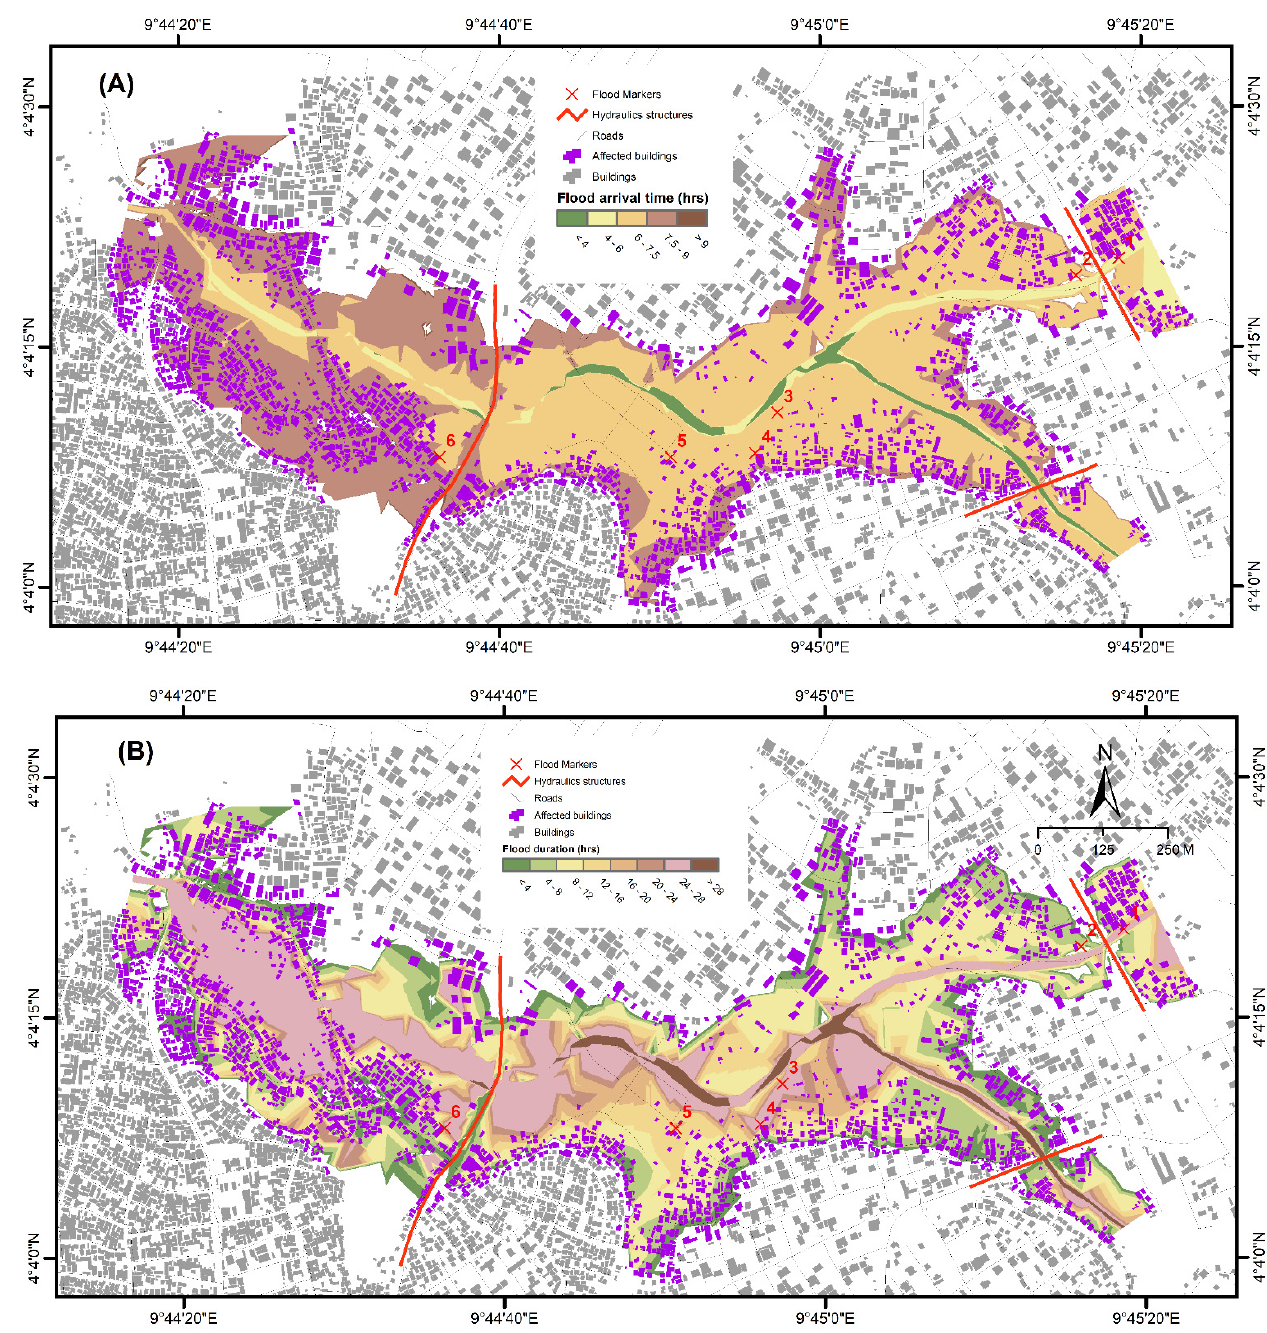
Figure 8. ( A ) Flood arrival. ( B ) Flood duration for 0.5 m